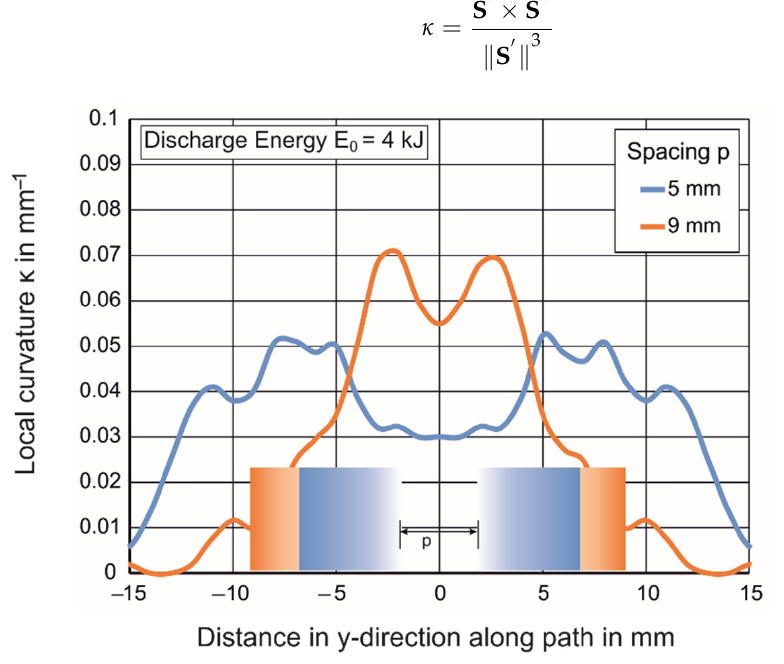
Figure 19. Change in local workpiece curvature for coil spacings of 5 mm and 9 mm.